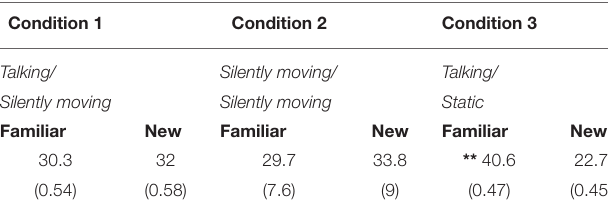
TABLE 1 | Mean looking times in seconds in front of the familiar and new faces at test